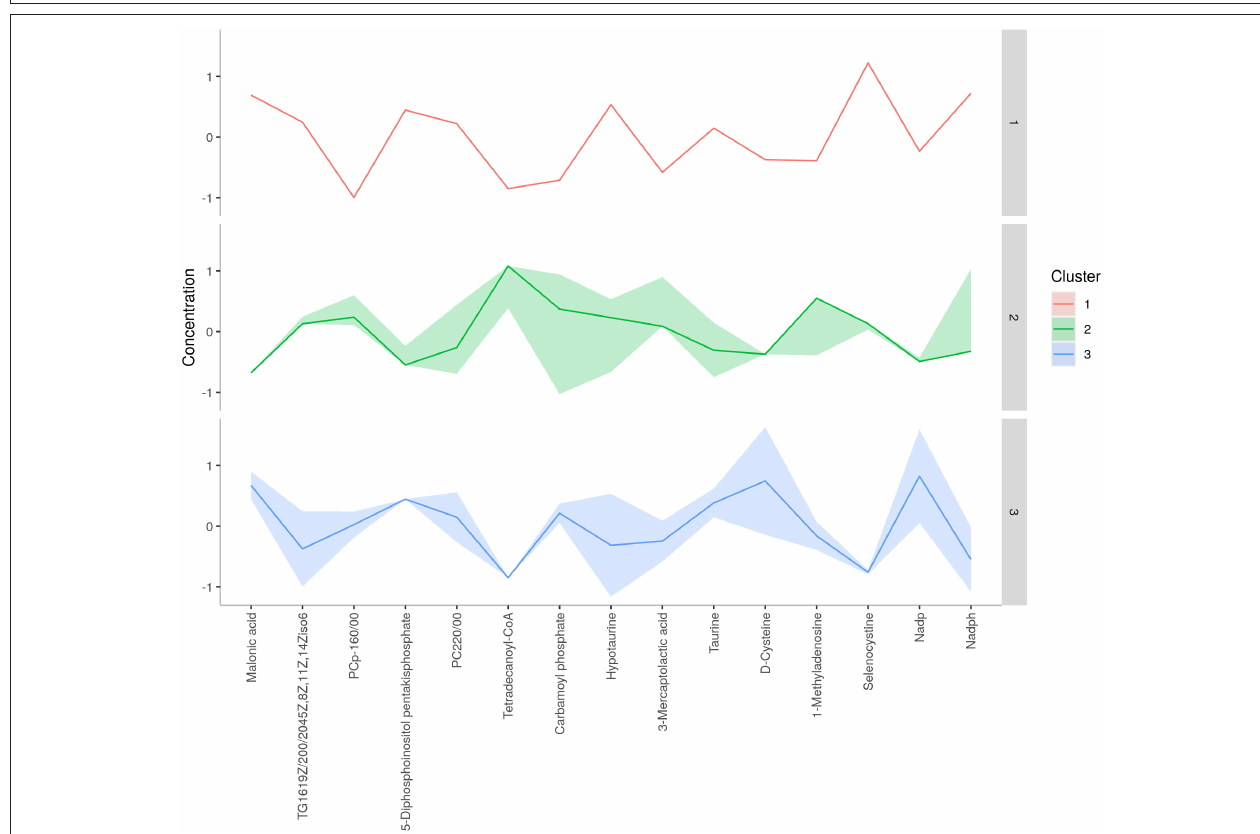
FIGURE 6 | K -means clustering of seminal plasma metabolites of astheno-oligozoospermia bulls. The metabolome view of the graphical output of pathway analysis is presented in Supplementary Figures 11A,B .